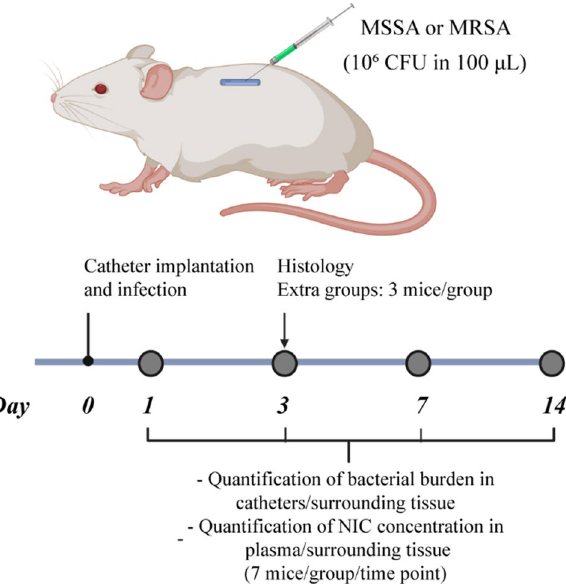
Figure 2. In vivo efficacy evaluation of non-loaded, 2 and 5% (w/w) NIC loaded TPU catheters using a murine BAI model. Two 1 cm catheters segments were implanted subcutaneously in the mice and a bacterial challenge (10 6 CFU in 100 μL) of either MSSA or MRSA was injected intraluminally into each catheter. Blood, catheter segments, and the surrounding tissue were collected of mice sacrificed on day 1, 3, 7 and 14 after challenge. Bacterial colonization of the catheter and the surrounding tissue, and the NIC concentration in plasma and in the tissue surrounding the catheter were